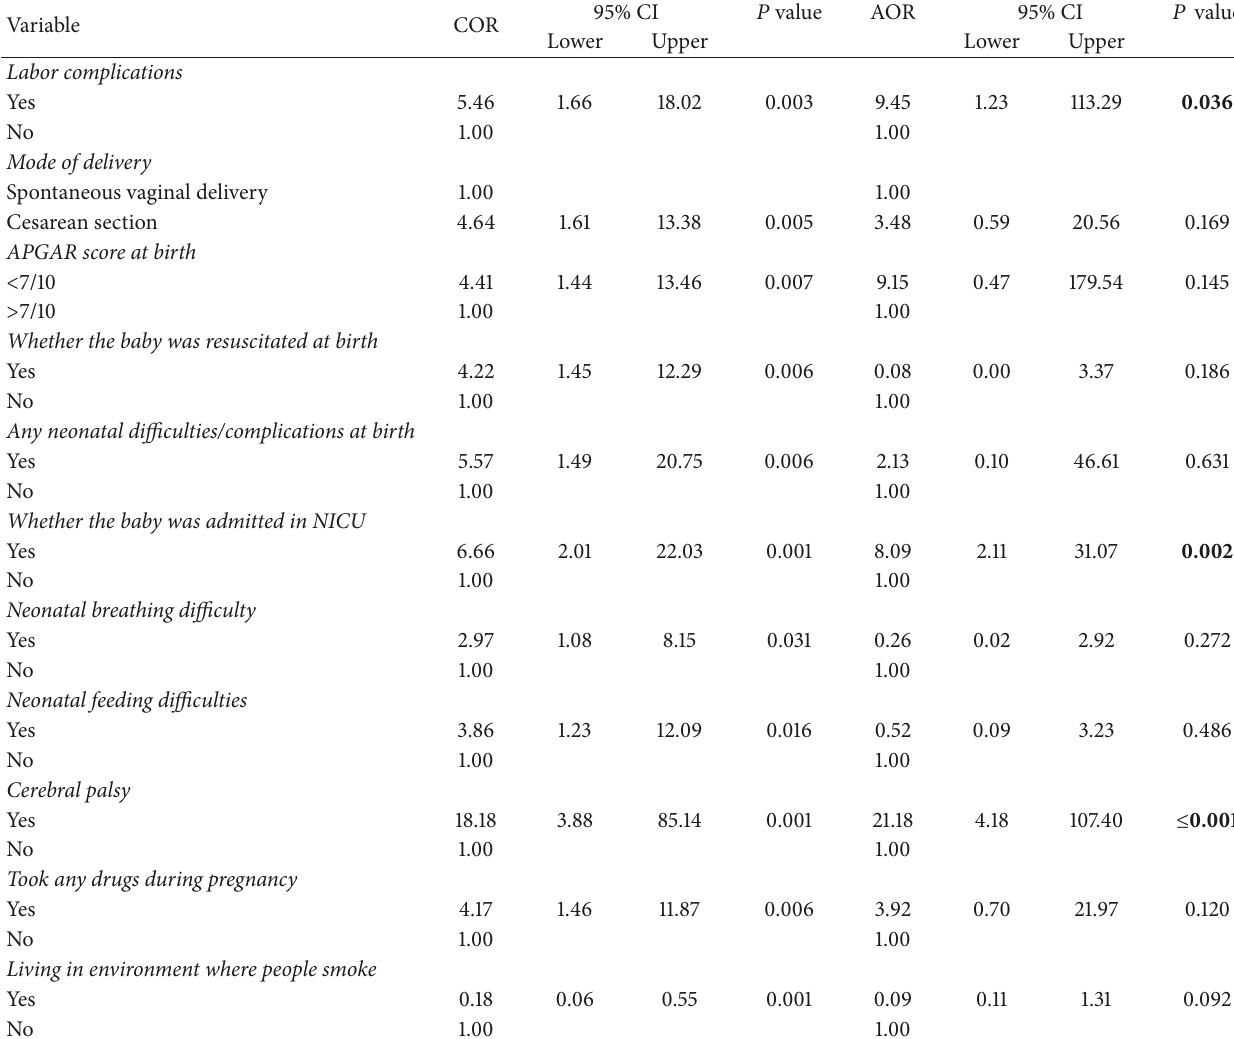
Table 10: Factors associated with severity of intellectual disability among